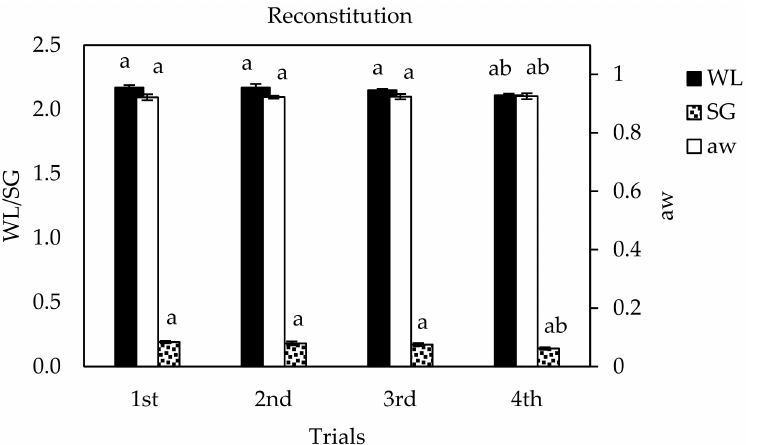
Figure 3. Comparison of a 3-times reconstituted OD solution (4 consecutively trials of OD treatments) on WL, SG and a w of fig halves processed at optimal OD conditions (45 ◦ C, 90 min, 1/4 ratio of sample per OD solution ( w s / w OD )). Error bars represent standard deviation from multiple replications of treatments. Different small letters indicate significant different means ( p < 0.05) within different OD